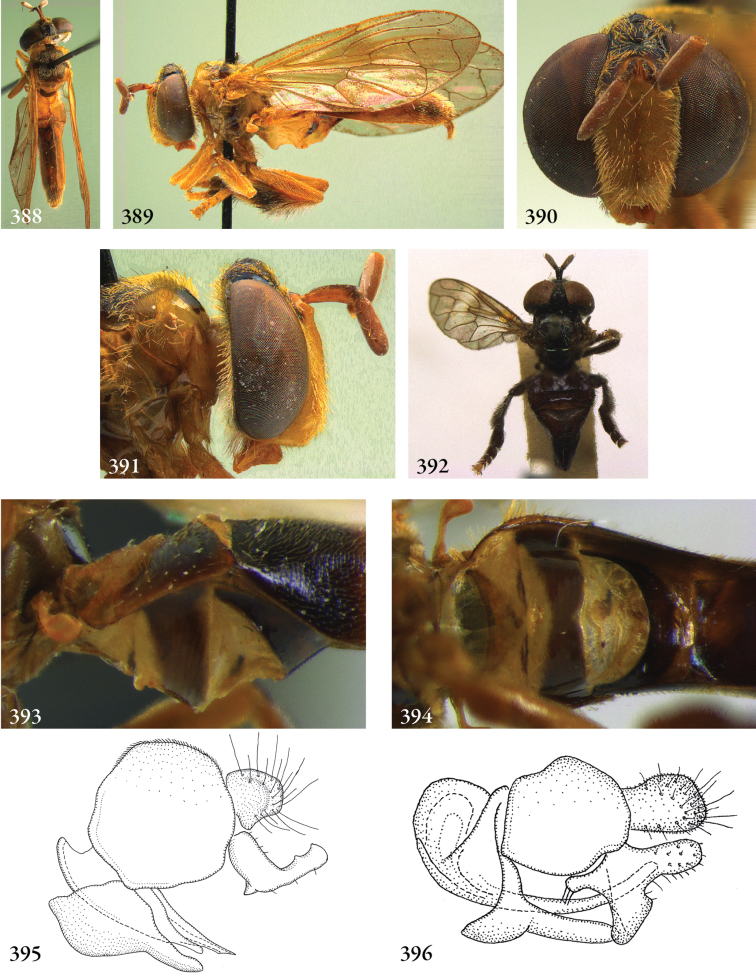
388–391
Stipomorpha tenuicauda female (holotype) 388 habitus dorsal 389 habitus lateral 390 head frontal 391 head lateral 392
Stipomorpha lacteipennis male (holotype), habitus dorsal 393–394
Stipomorpha goettei male (Surinam, coll. RMNH), base of abdomen: 393 lateral 394 ventral 395–396
Stipomorpha, male genitalia: 395
Spheginobaccha tenuicauda (Bolivia, coll. M. Hauser) 396
Spheginobaccha lacteipennis (Surinam, coll. RMNH).